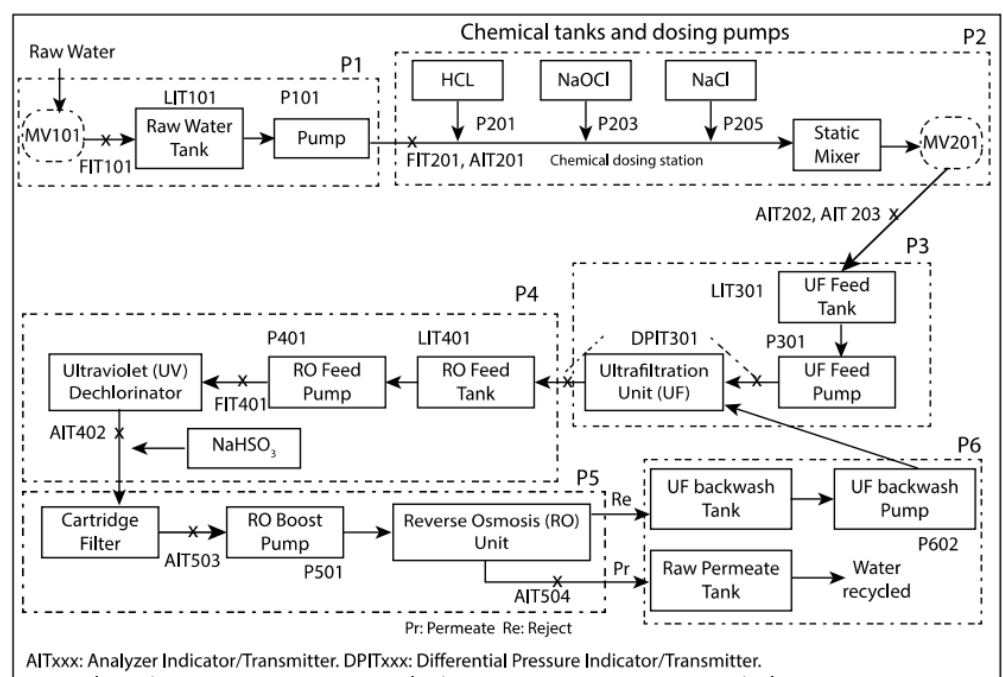
Figure 5. Overview of the Secure Water Treatment testbed showing the processes segmentation along with the location of sensors and actuators within the system [38].